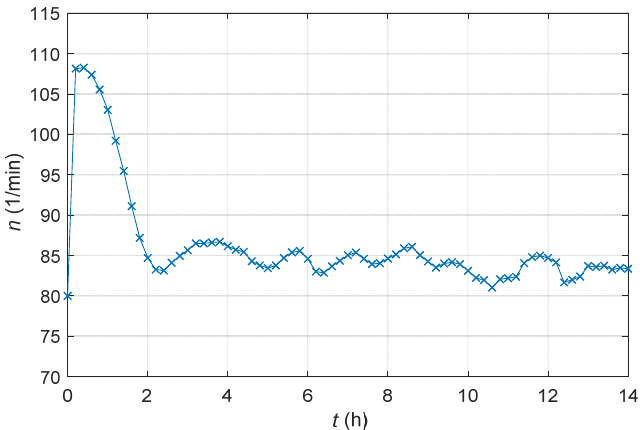
Figure 9. Time course of the measured stirrer speed n of the laboratory batch bioreactor with an AMFC system.